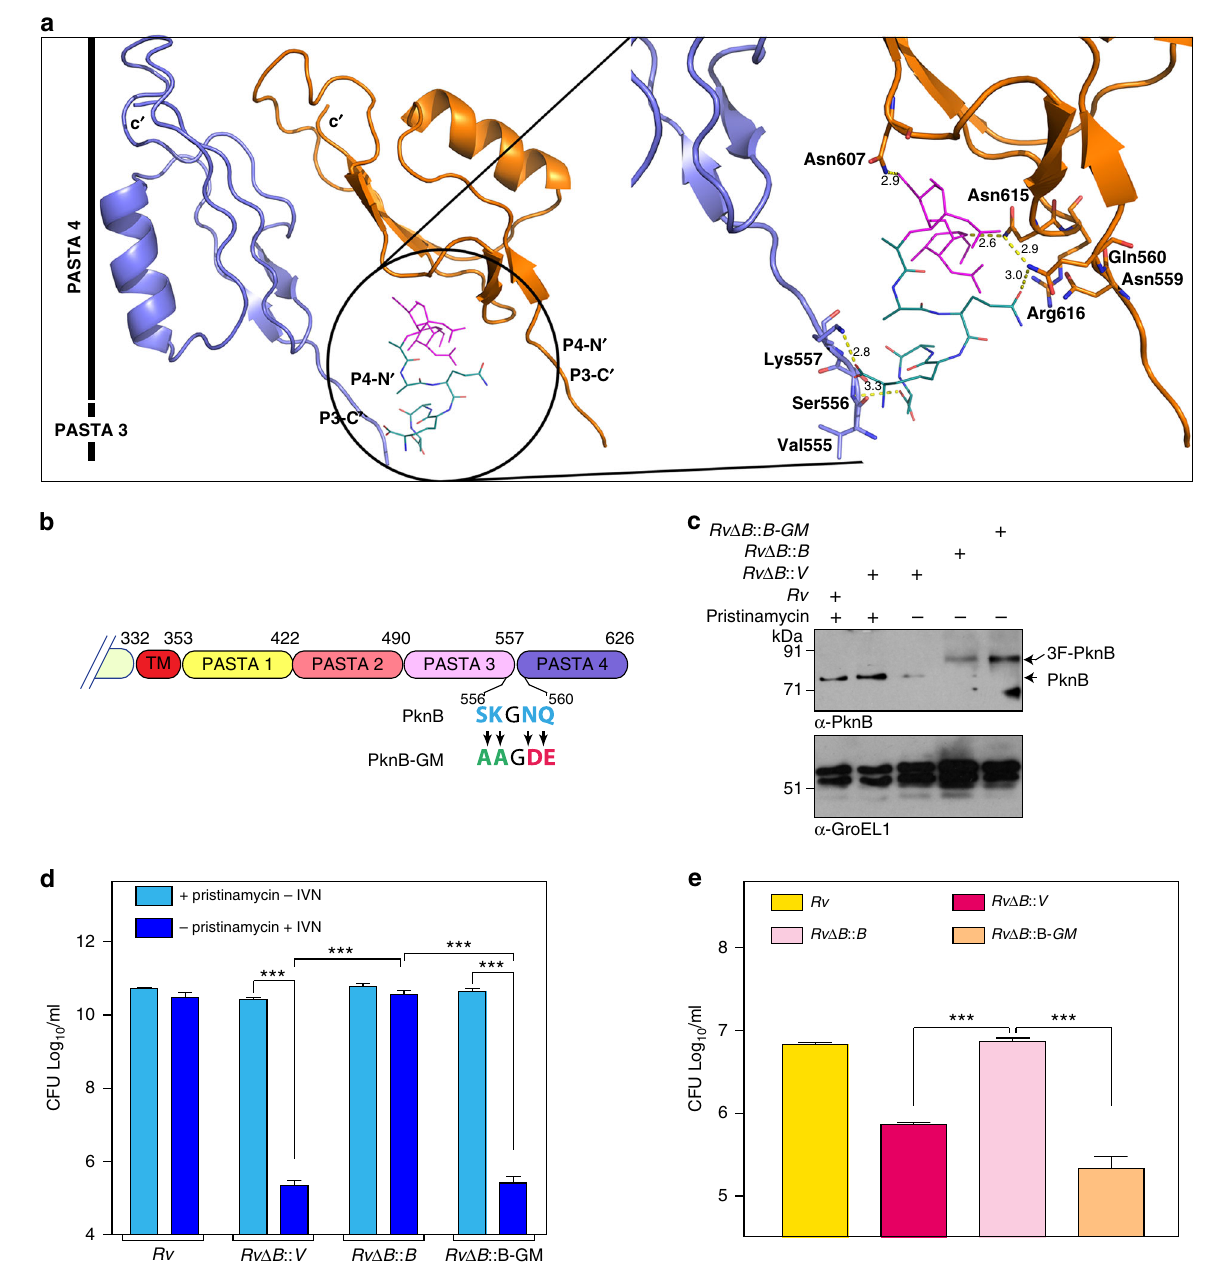
Fig. 2 mDAP and iGln interacting residues in fl uence the survival. a Model of Mtb PknB PASTA3-4 dimer in complex with the muropeptide ligand. Inset panel shows a magni fi ed view of the interactions between the mDAP and iGln residues of the muropeptide with polar amino acids between the PASTA3 and 4 domains of PknB. b Schematic representation of extra-cytoplasmic PASTA domain of PknB and the residues in the PASTA3-4 linker region suggested to be involved in interaction with iGln (SK) and mDAP (NQ) residues in the muropeptide. The mutations introduced in the linker region to generate PknB- GM are indicated. c Western blot analysis of WCLs prepared from Rv and Rv Δ B transformants. The transformants were seeded at A 600 of ~0.05 in the presence of pristinamycin or IVN as indicated for 5 days and WCLs were resolved on 8% SDS-PAGE and probed with α -PknB and α -GroEL1 antibodies. d Cultures of Rv and Rv Δ B transformants were initiated at A 600 of ~0.05 and grown in the presence of 1.5 μ g/ml pristinamycin or 0.2 μ M IVN as indicated for 6 days. CFUs were evaluated by plating appropriate dilution on 7H11 agar plates containing pristinamycin. Data are representative of the three biologically independent experiments and each experiment was performed in triplicates. e Human monocytic cell line THP-1 was differentiated to macrophages and was infected at 1:10 M.O.I. with Rv and Rv Δ B transformants grown to A 600 of ~0.6 – 1.0 in the presence of pristinamycin. IVN was added in the media to induce the expression of episomal copy and CFUs were enumerated 72 h p.i. Data are representative of one of the two biological replicates and each experiment was performed in triplicates. Data represents mean + SD. Statistical analysis was performed with the unpaired t -test using Graphpad software. *** p < 0.0005. Source data are provided as a Source Data fi